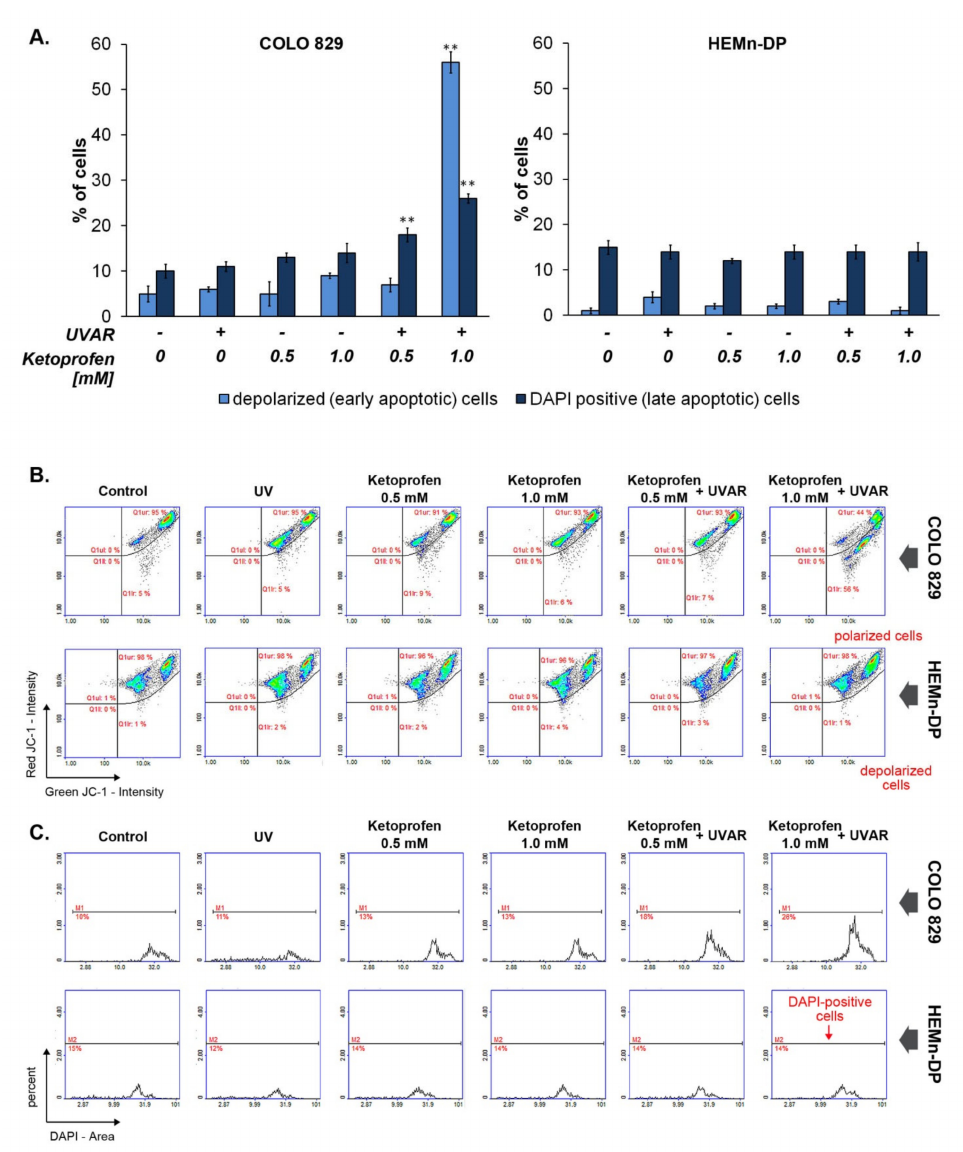
Figure 3. The mitochondrial transmembrane potential in melanotic COLO829 melanoma cells and human melanocytes HEMn-DP after co-treatment with KTP and UVAR. ( A ) Bar graphic representing changes in the proportion of cells with depolarized mitochondria and late apoptotic cells. ( B ) Scatter plots demonstrating changes in JC-1 intensity in tested cells. ( C ) Scatter plots showing changes in DAPI intensity in the studied cells. Mean values ± SD from three independent experiments performed in triplicate ( n = 9) are presented. ** p < 0.001 vs. control (one-way ANOVA, two-way ANOVA, Tukey’s